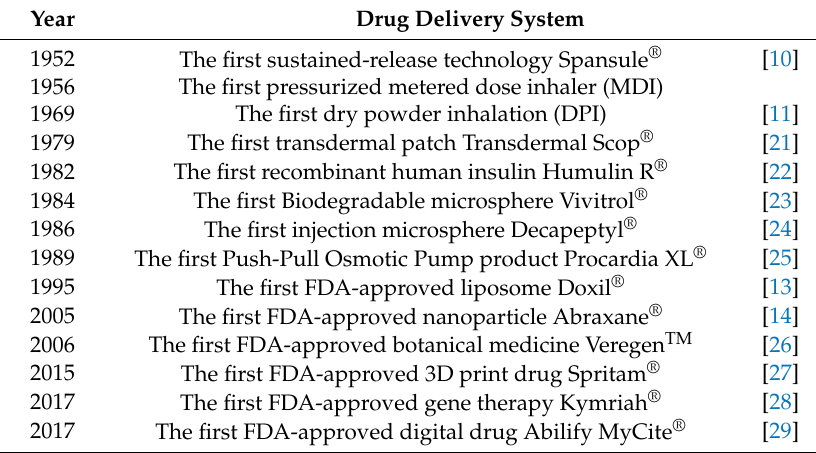
Table 1. The landmark of key drugs delivery technologies to the